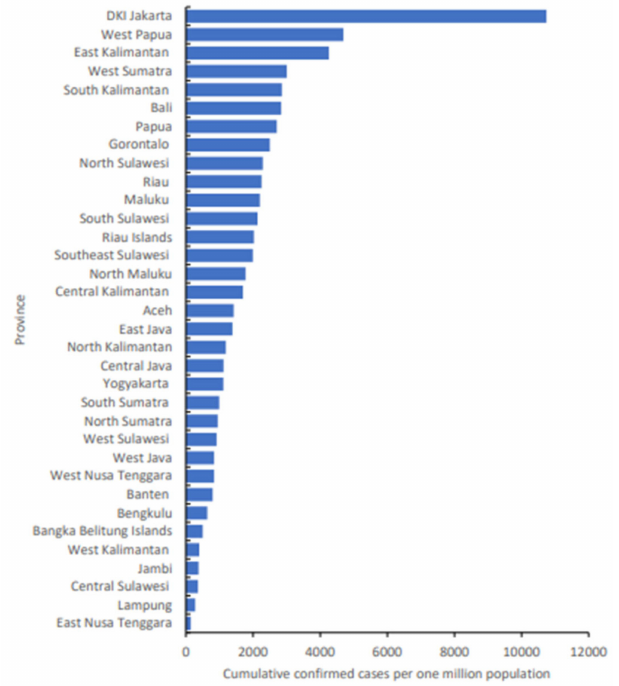
Figure 3. Daily number and cumulative cases of COVID-19 in Indonesia as of 14 November 2020, Source: